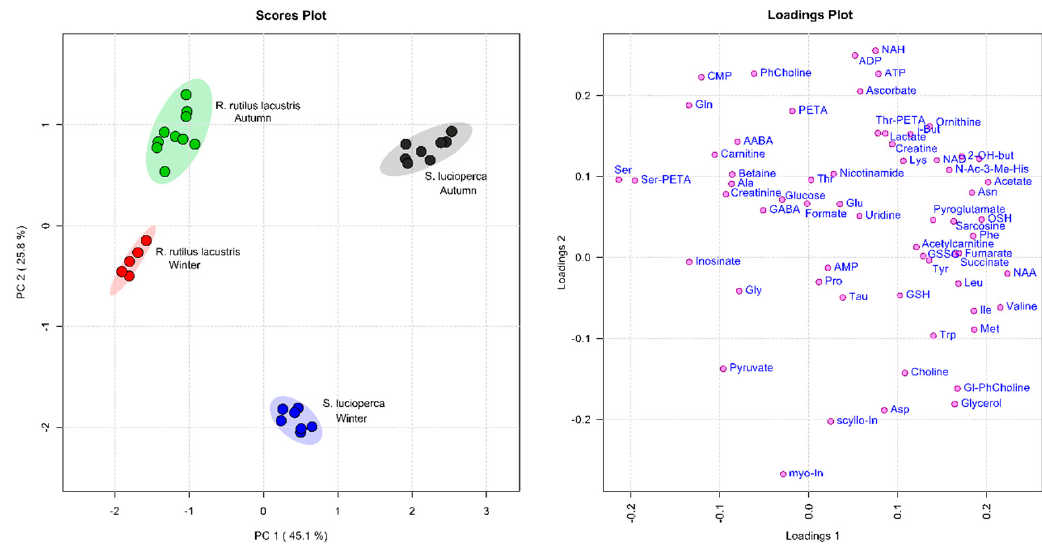
Figure 3. Scores ( left ) and loadings ( right ) plots of principal component analysis (PCA) of lens metabolomic profiles of S. lucioperca caught in autumn (black) and winter (blue) periods and R. rutilus lacustris caught in autumn (green) and winter (red) periods. The data are range scaled. Colored ovals indicate 95% confidence regions. Variance explained by the first (PC1) and second (PC2) principal components are indicated on the axis of scores plot.